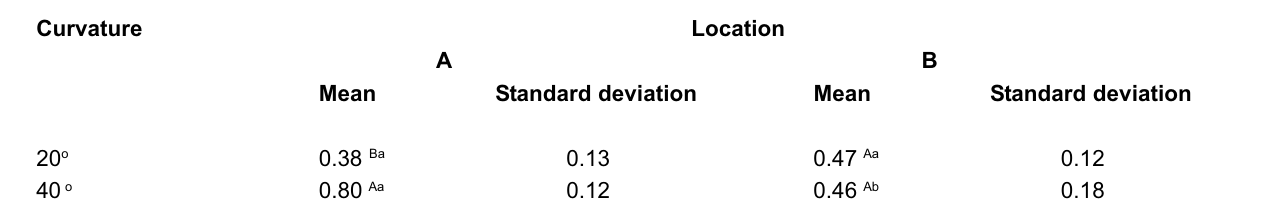
Means followed by different uppercase letters in columns and different lowercase letters in rows differ significantly (p<0.05; ANOVA and Tukey’s test). TABLE 3- Wear means (mm) according to the instrument size